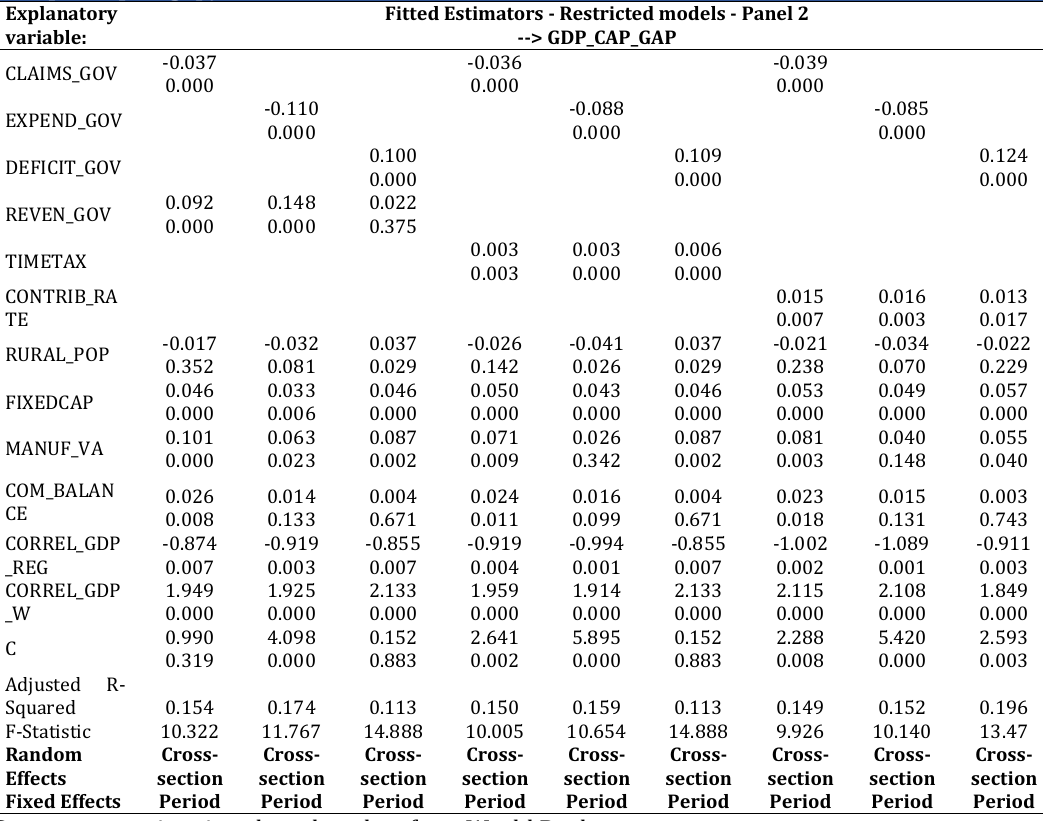
Table 7: Fitted estimators with random effects / fixed effects – Panel 2 (dependent variable GDP per capita